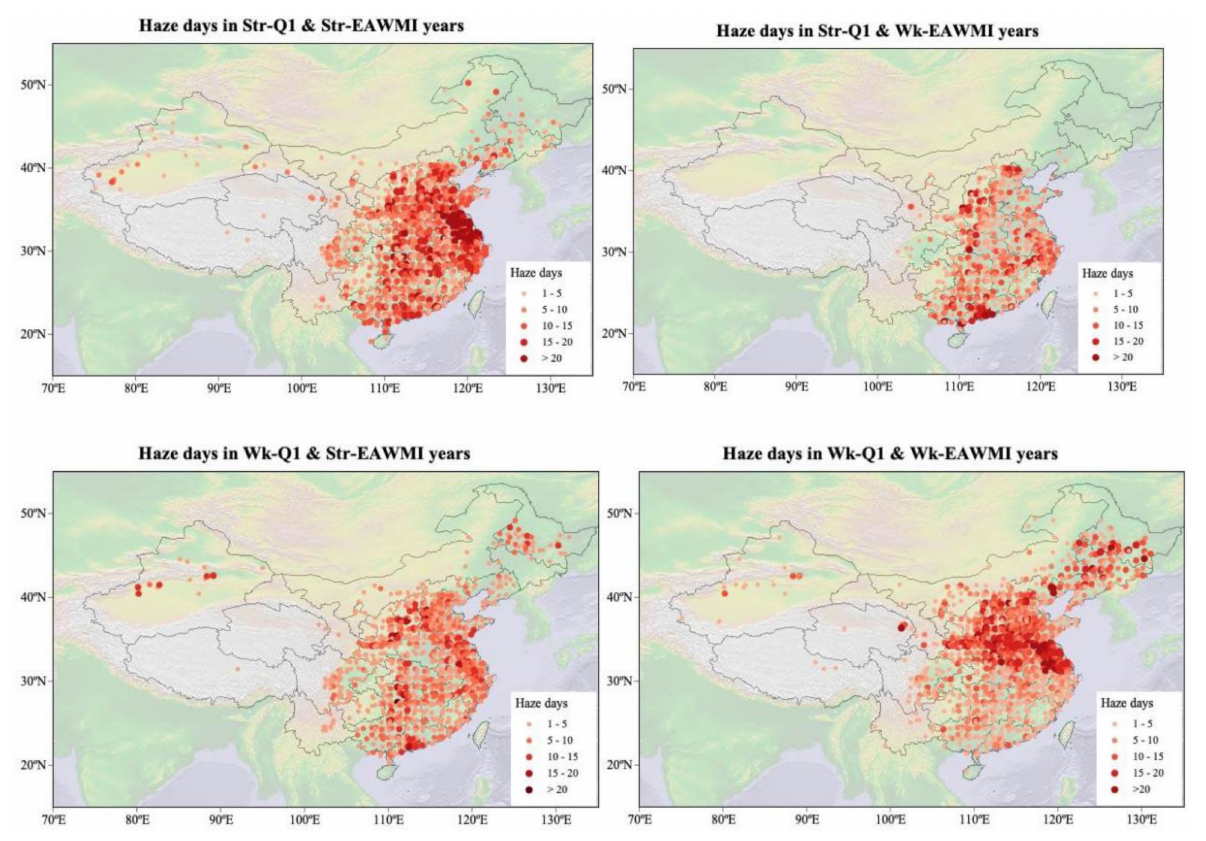
Figure 4. Distribution of haze days under four different combined years with strong, weak cold sources and winter monsoons in